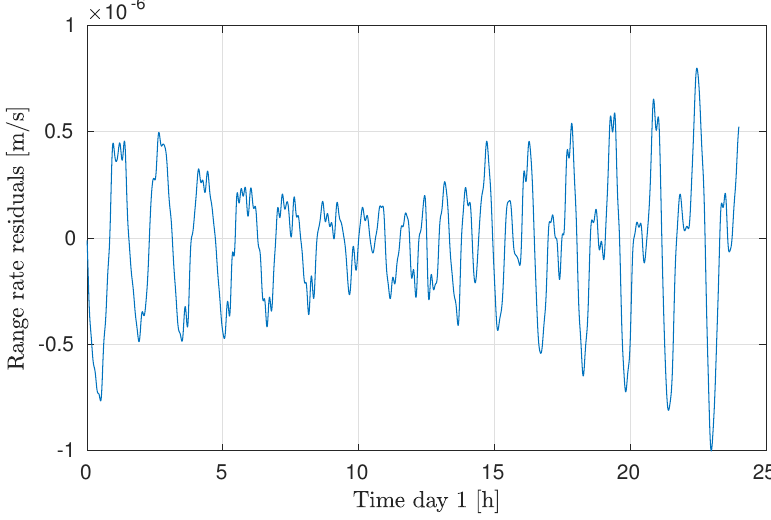
Figure 4. Time series of range rate residuals for Day 1 after the sixth